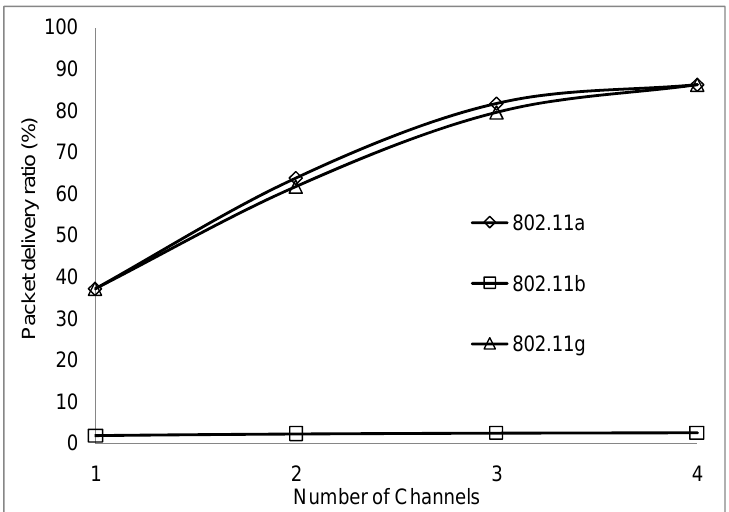
Figure 34. Delivery ratio at 50 m range and data rate of 54 Mbps.